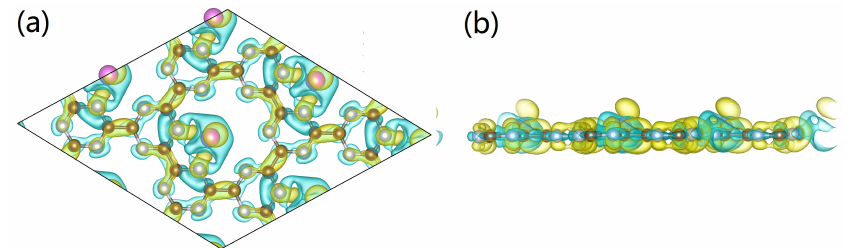
Figure 4. ( a , b ) Charge density difference for the Al-doped g-CN. Yellow regions indicate charge gain and the blue regions indicate charge loss. The isosurface of charge density is 0.0026 e/Bohr 3